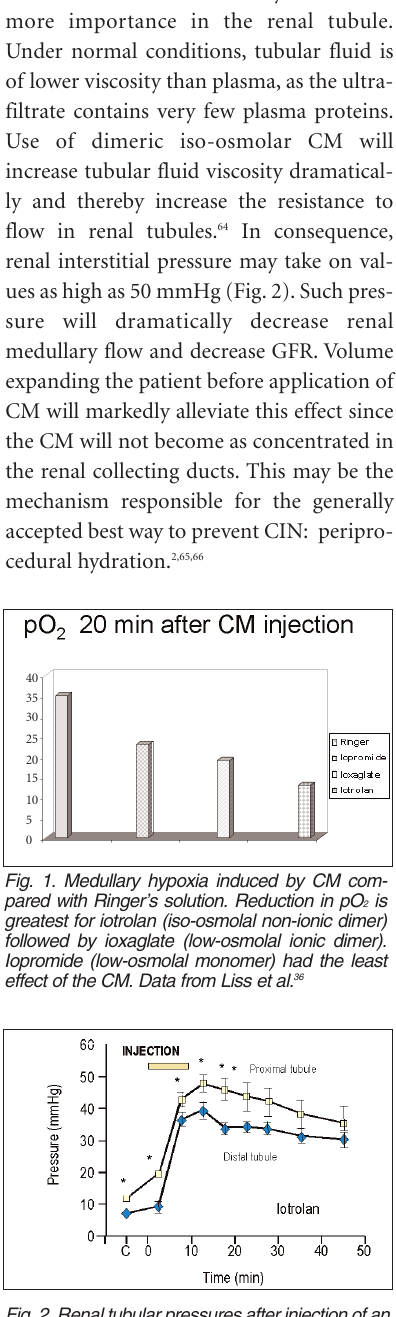
Fig. 2. Renal tubular pressures after injection of an iso-osmolar non-ionic CM, iotrolan. (Data from Ueda et al. Acta Radiol 1998; 39: 90 -